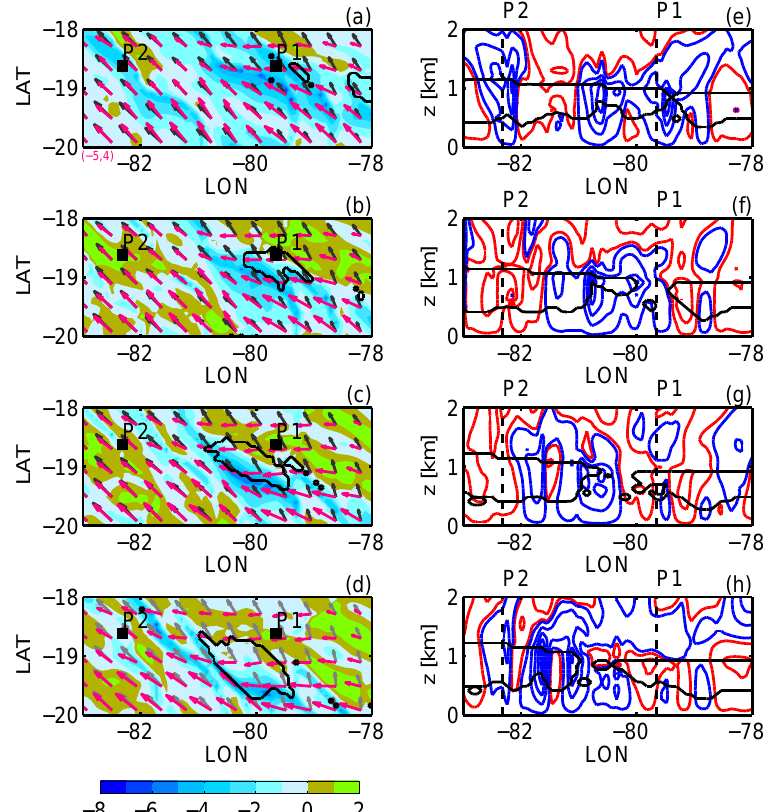
Fig. 10. Left panels: vertical velocity (in color) on level 14 ( z = 1000m) and 1 (gm − 2 ) LWP contour (black line) for times 9.15, 10.15, 11.15, 12.15 UTC (panels a – d ); gray arrows: horizontal velocity on level 12 ( z = 780m), magenta arrows: horizontal velocity above the boundary layer on level 19 ( z = 1300m). Red numbers below the upper left panel define the velocity vector in the lower left corner of the panel. Right panels: vertical cross section through the computational domain for the latitude 18.62S. Red/blue: contours of the positive/negative vertical velocity starting from 0.2/ − 0.2cms − 1 , every 1cms − 1 . Black line: contour of the q c =0.1gkg − 1 . Positions of column P1 and P2 are shown in the left panels.